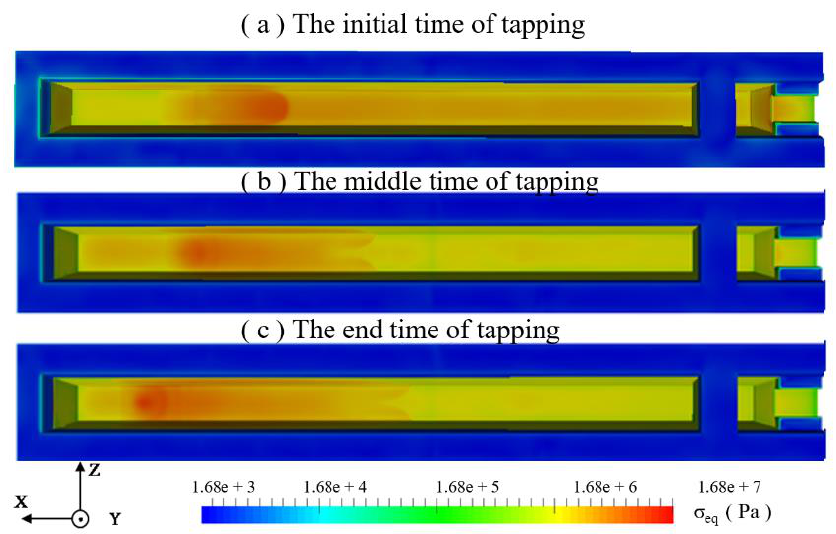
Figure 10. Equivalent stress distribution of the main trough at different times. The stress value near the hot metal drop point is larger than at other positions. Three cross-sections at 3.5 m, 4 m and 4.5 m were selected for analysis and the results are shown in Figure 11. The temperature gradient on the surface of the lining is large, forming a thin stress-concentration layer. The temperature gradient in the early stage of the tapping is relatively large, so the range of the high-stress distribution is larger than that in the middle of the tapping. However, as the tapping continues, the turbulence in the main trough changes, the temperature gradient in the refractory material increases, and the stress-affected area expands again.